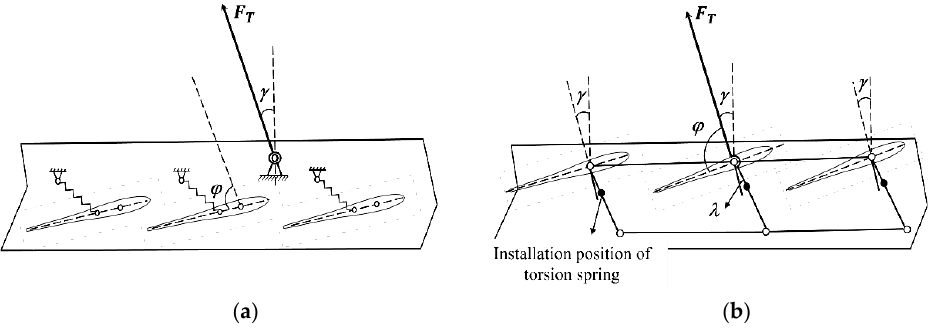
Figure 4. The structure comparison of the SALL submerged glider and the conventional submerged glider. ( a ) Conventional submerged glider; and ( b ) self-adjusting lower-limit submerged glider.